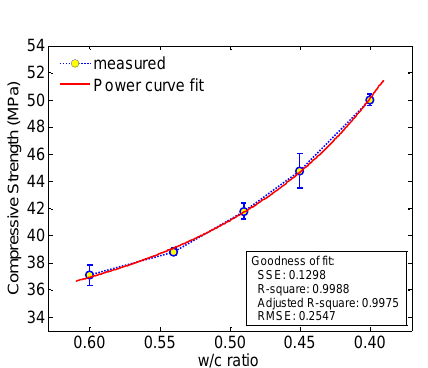
Figure 4. Measured average compressive strength and standard deviation versus w / c ratio.